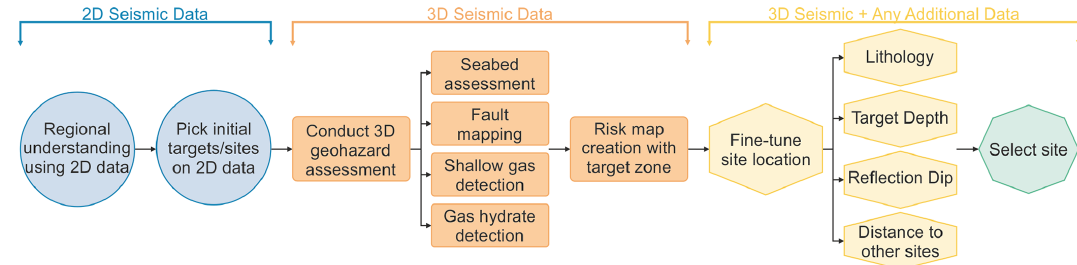
Figure 5. A workflow diagram that outlines both the steps conducted within the geohazard assessment leading to site selection and how the differing seismic data types were used throughout the process. This workflow should be used as a guide for future geohazard assessments using 3D seismic data but is not fully exhaustive and can be amended to fit different datasets and locations through the addition of extra steps that fulfil the requirements of future